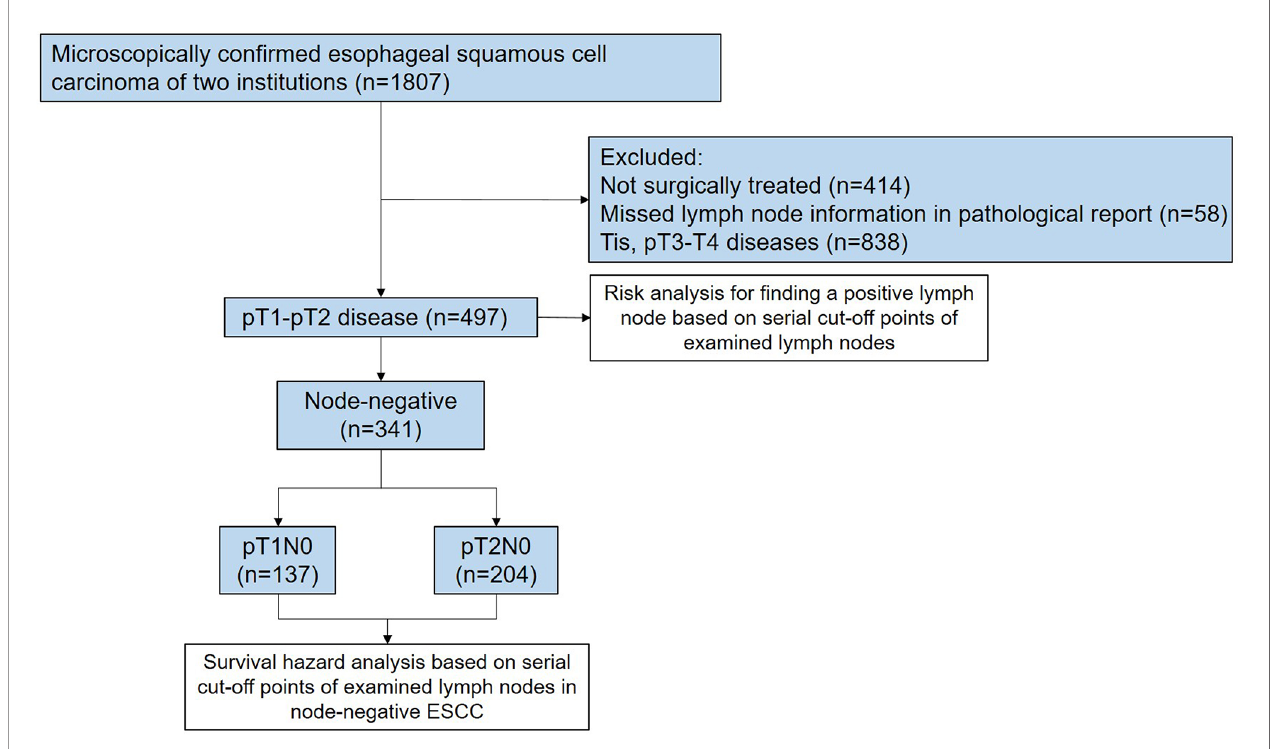
FIGURE 1 | Diagram of patient selection and